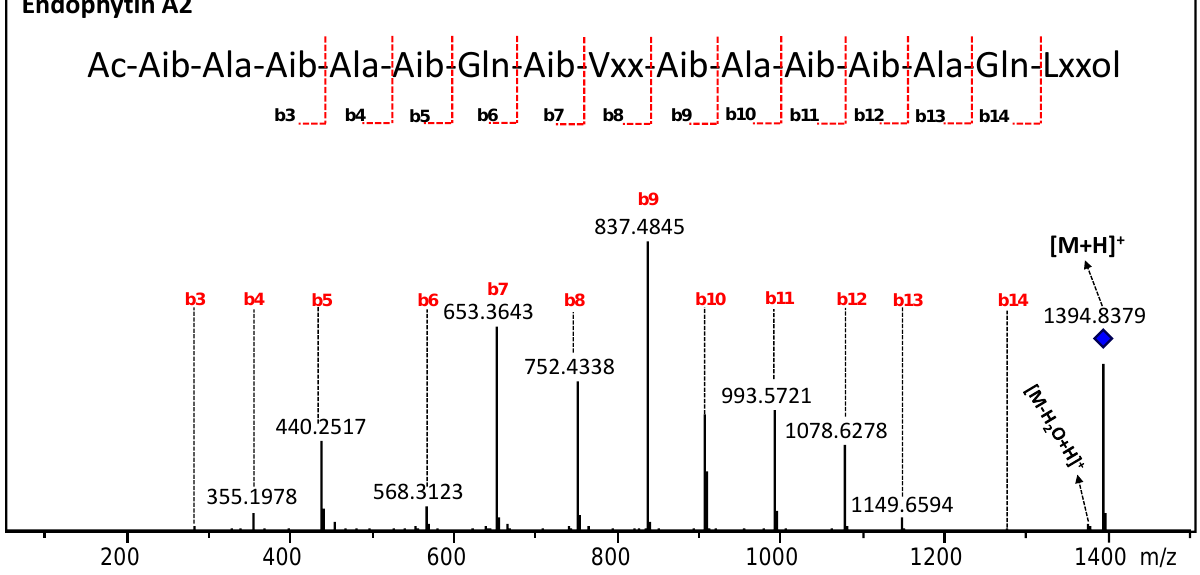
Figure 6. MS/MS sequencing of peptaibol endophytin A2 (diamond). The sequences are given in standard spelling code (Vxx, Val/Iva, Lxx, Leu/Ile and Lxxol represent the C-terminal amino alcohol). The 21 new sequences of peptaibols identified in this work (Tables 1 and S3) Table 1. New endophytins A1-A13 and B1-B8 produced by T. endophyticum MMSRG85.